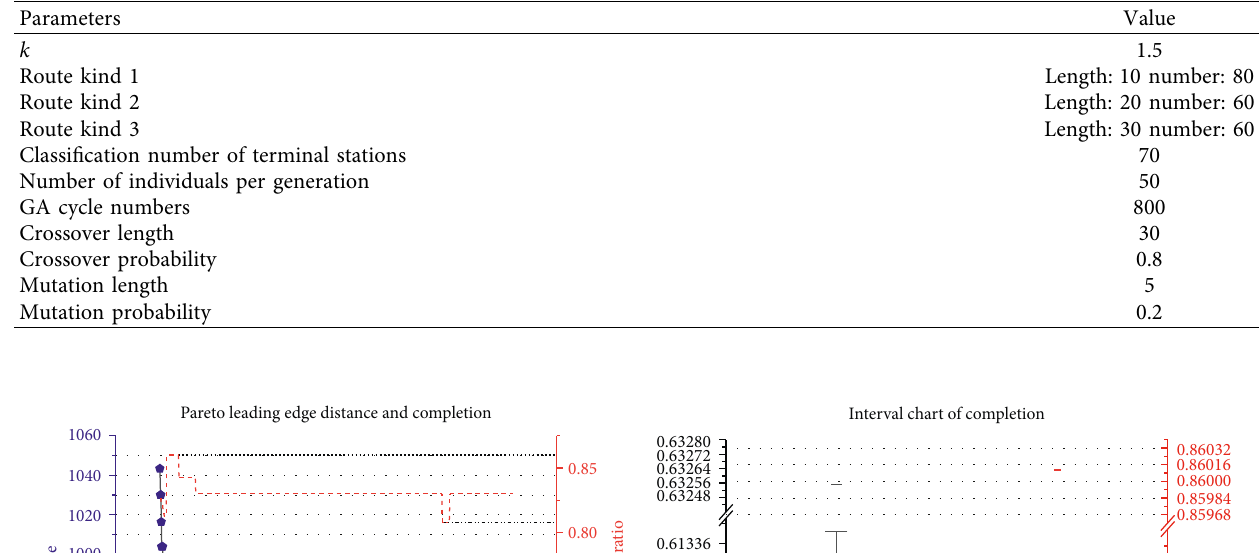
Table 3: Parameters used in